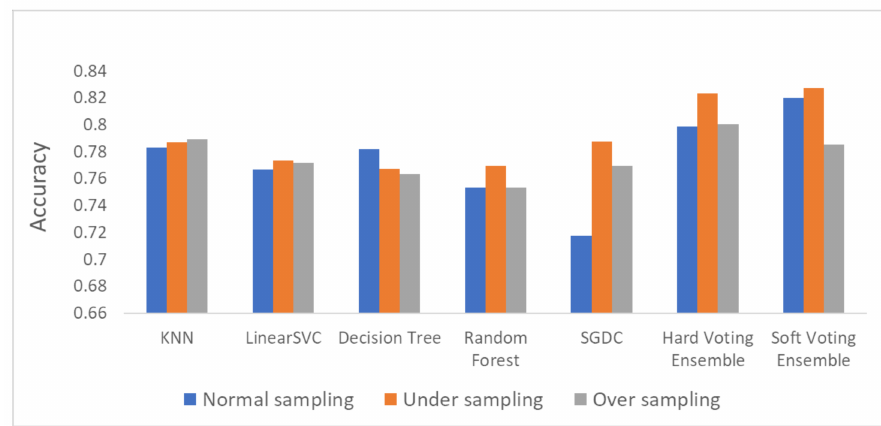
Figure 9. Overall accuracy results.